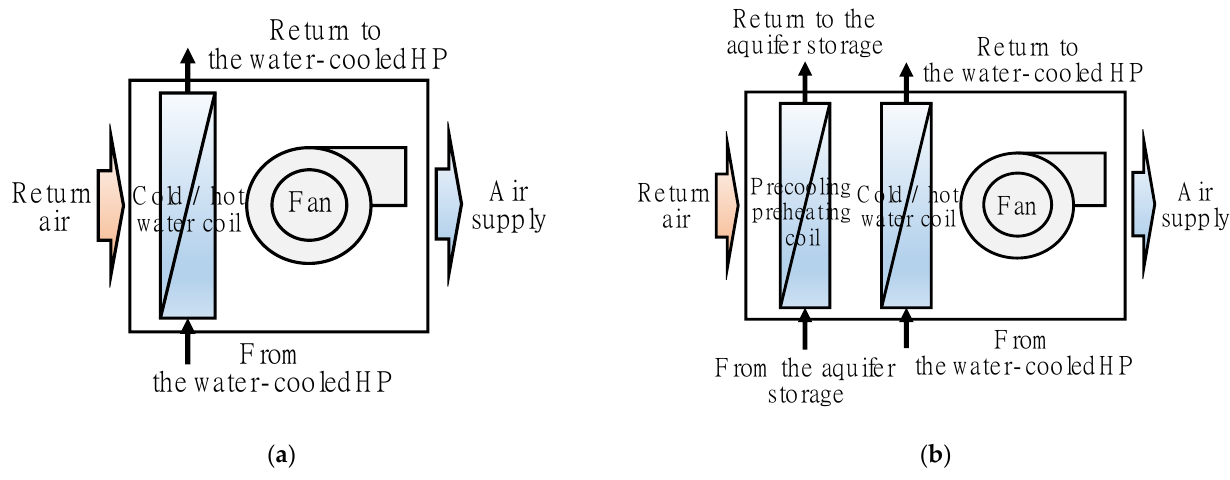
Figure 8. Configuration of the AHU. ( a ) Cold/Hot water coil. ( b ) Pre-cooling/Pre-heating coil.